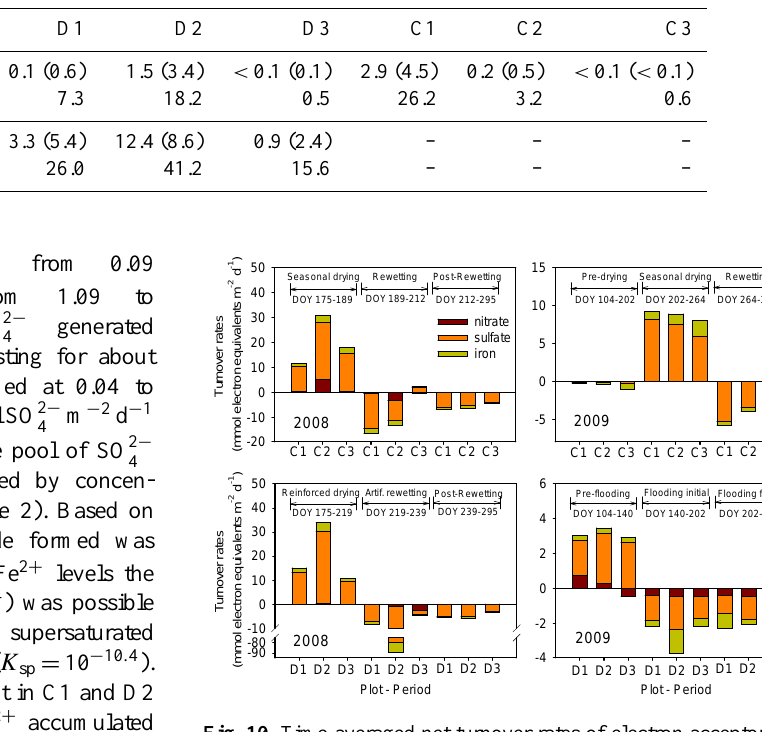
Fig. 10. Time-averaged net turnover rates of electron acceptors in- tegrated for 30cm profiles expressed in electron equivalents based on the dissolved concentrations measured (solutes) during different periods in all plots. Positive values refer to production (oxidation) and negative values to consumption